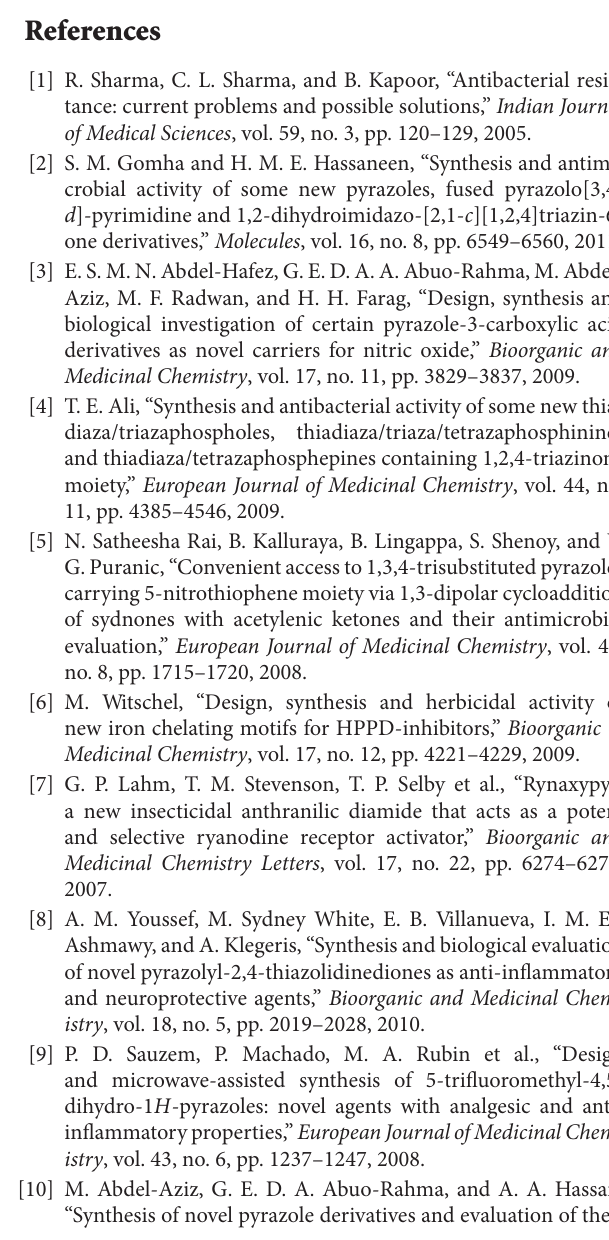
-pyrazoles (3a–g) 𝐻𝐻